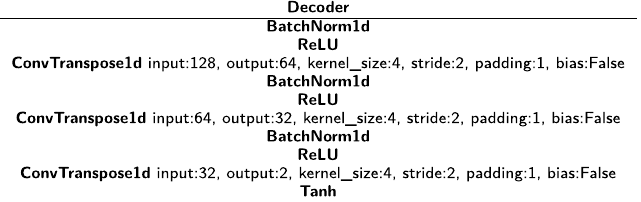
Table 2 Parameters and modules of the